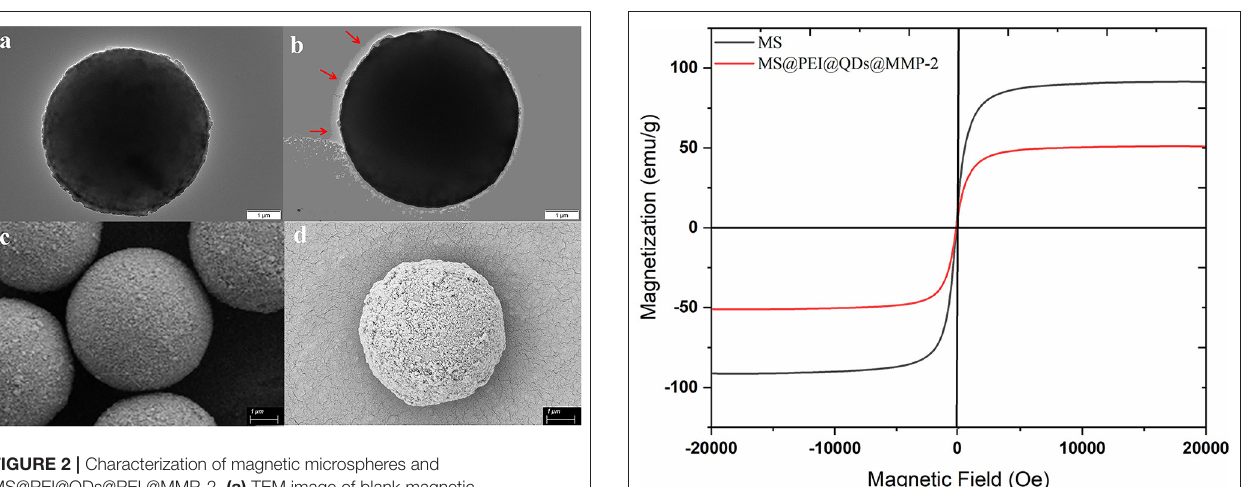
for the immobilization of MMP-2 onto the